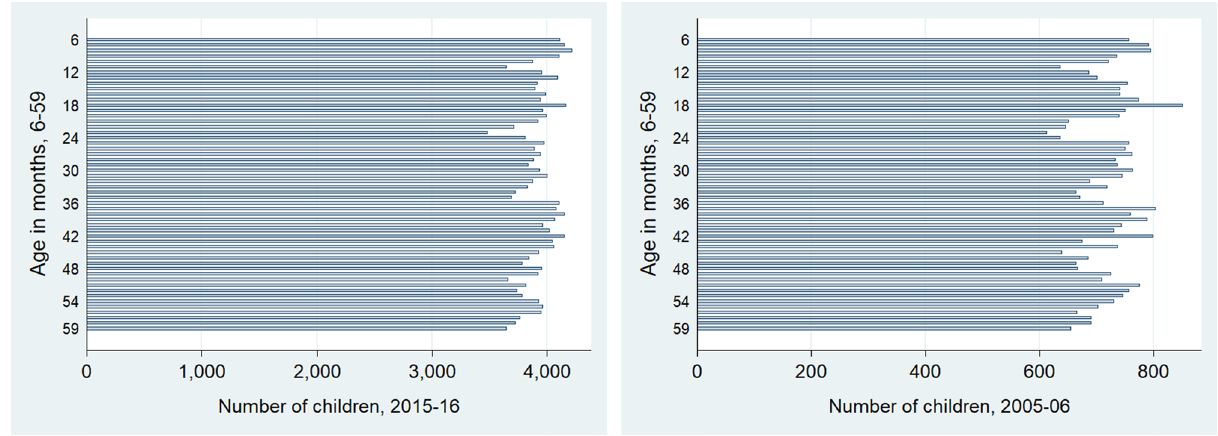
Figure 3. Age distribution in completed months. Smart WHO